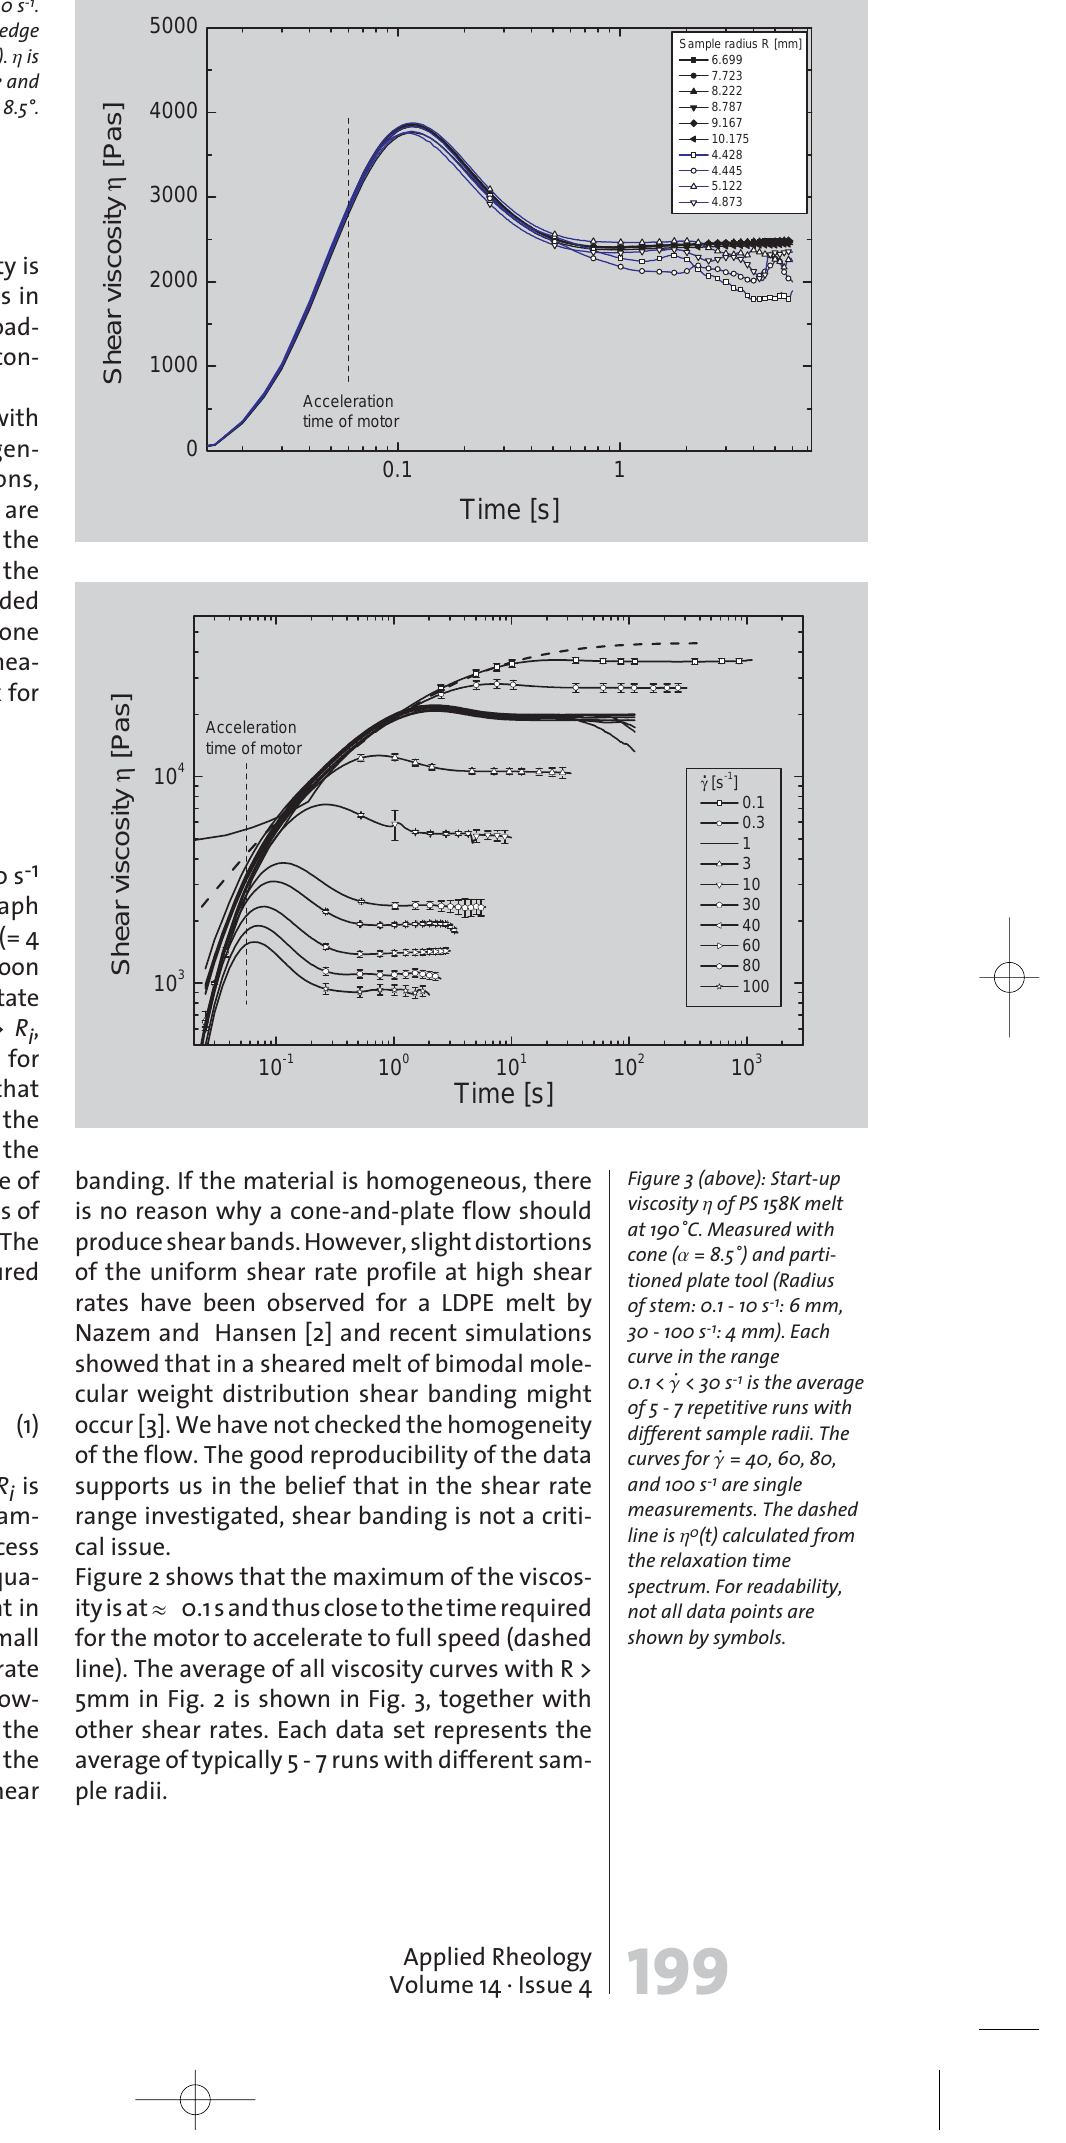
Figure 3 (above): Start-up viscosity h of PS 158K melt at 190˚C. Measured with cone ( a = 8.5˚) and parti- tioned plate tool (Radius of stem: 0.1 - 10 s -1 : 6 mm, 30 - 100 s -1 : 4 mm). Each curve in the range 0.1 < g · < 30 s -1 is the average of 5 - 7 repetitive runs with different sample radii. The curves for g · = 40, 60, 80, and 100 s -1 are single measurements. The dashed line is h 0 (t) calculated from the relaxation time spectrum. For readability, not all data points are shown by